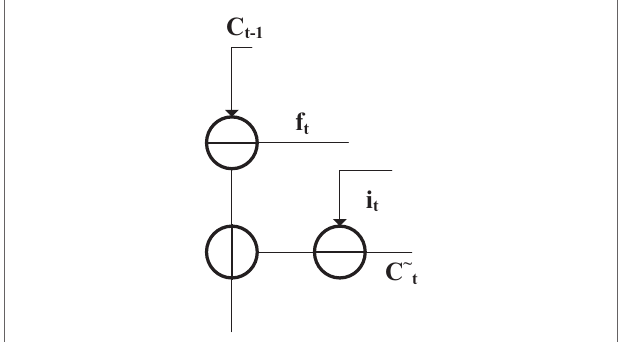
FIGURE 11 | State layer structure of memory unit.